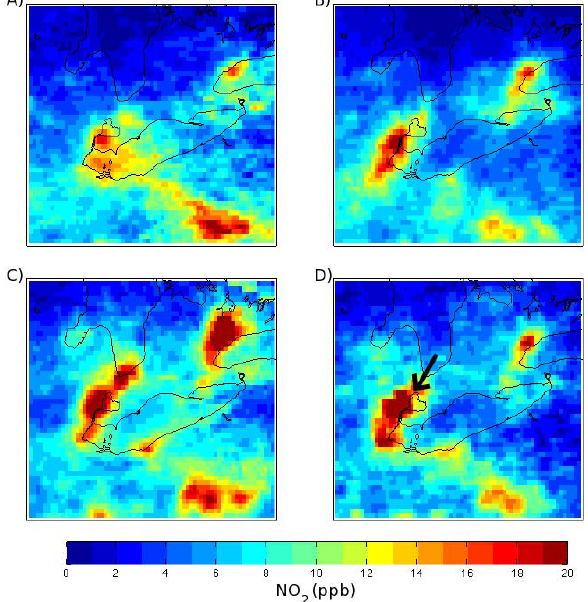
Fig. 11. OMI inferred NO 2 concentrations for summers of (A) 2006, (B) 2007, (C) 2008 and (D) 2009. Colour circles rep- resent average in situ measurements over the same time periods, on the same colour scale as the maps.